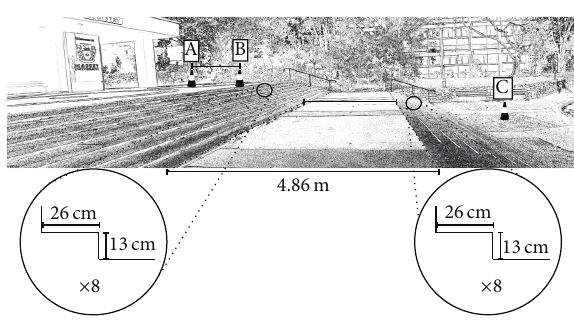
Figure 1: Pictorial representation of the experimental protocol, where A signifies the start point with the front wheel, B indicates the point at which timing commenced, and C is where timing ceased. The distance from A-B was dependent on the specific tyre rollout (see Table